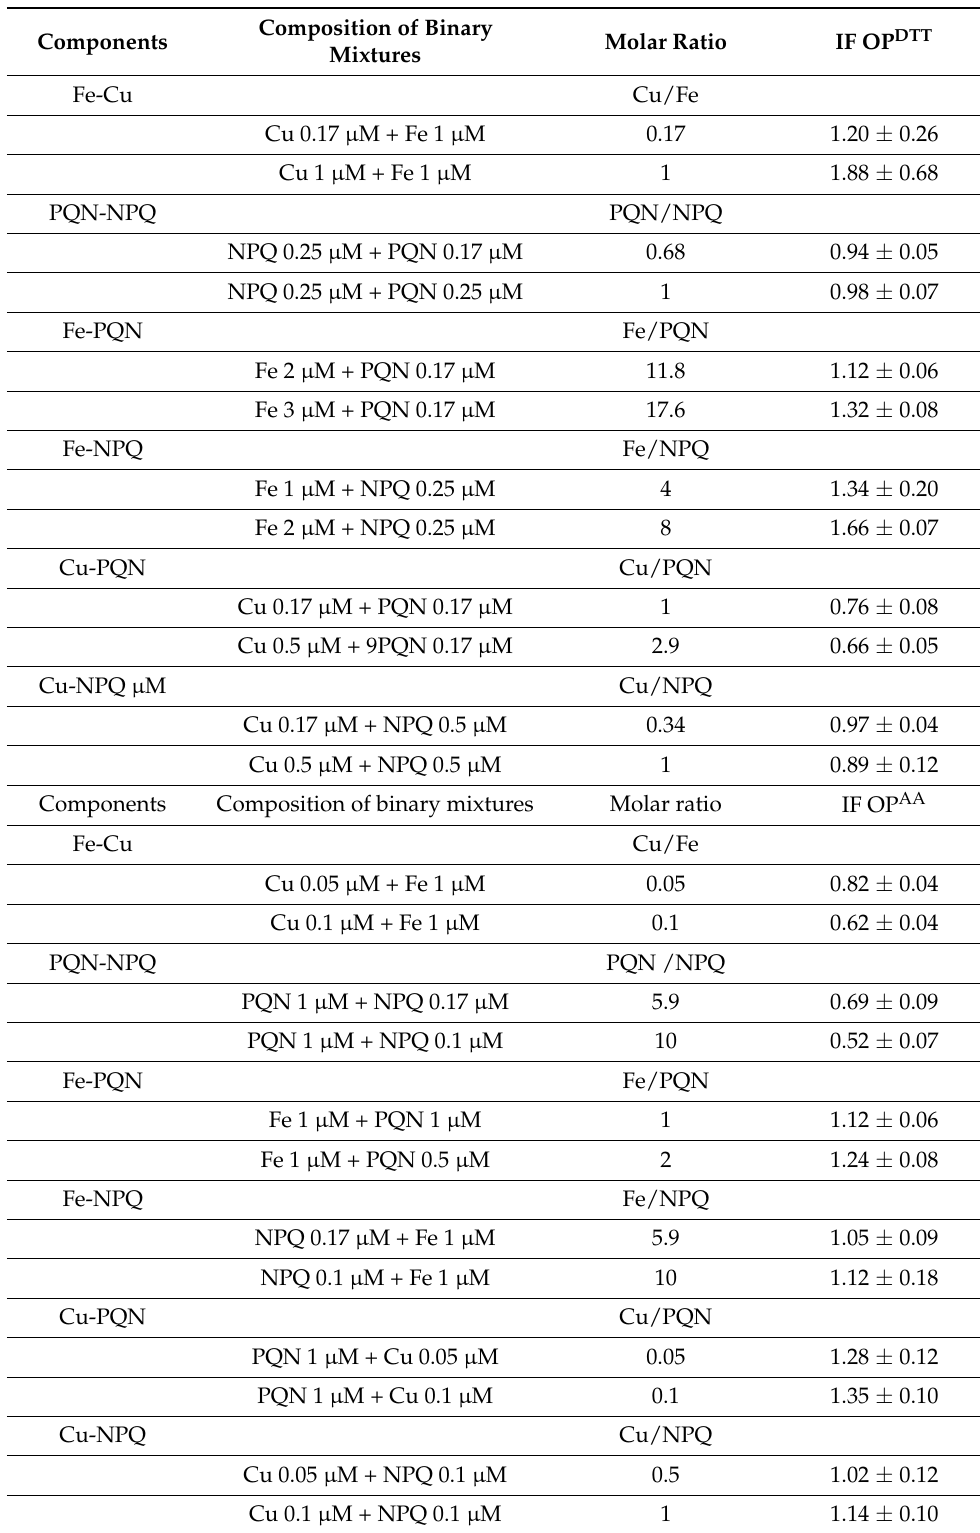
Table 2. Interaction factors (IFs) for DTT and AA consumption in the binary mixtures of metals and quinones. For each species pair, two concentration levels were investigated based on the concentration sets of individual standards reported in Table